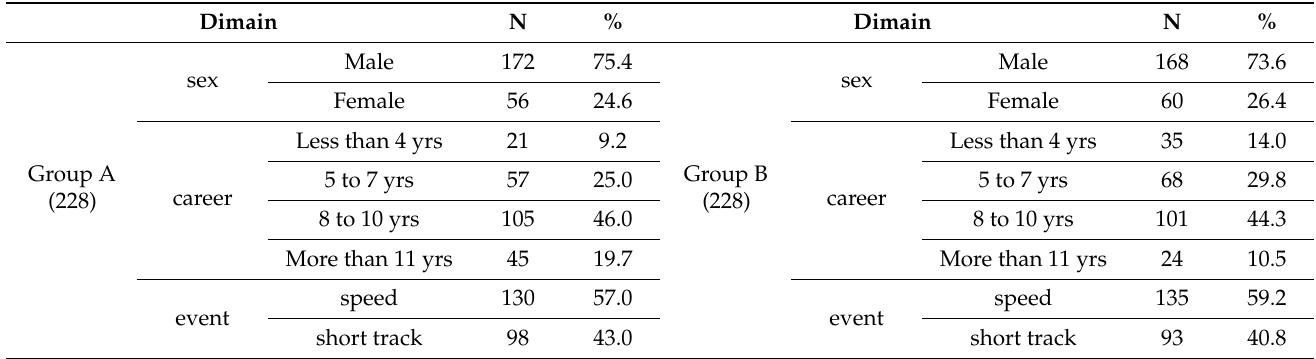
Table 2. General Characteristics of Survey